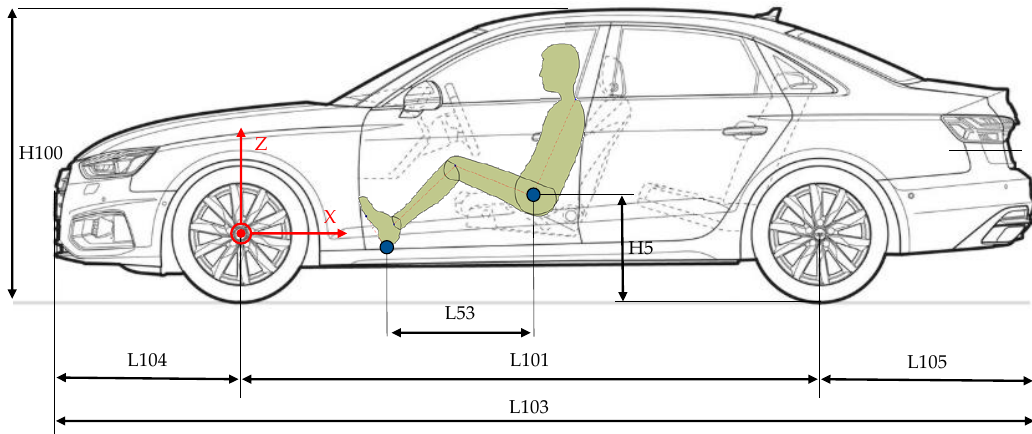
Figure 2. Some of the most important measures for the dimensional concept [26.]